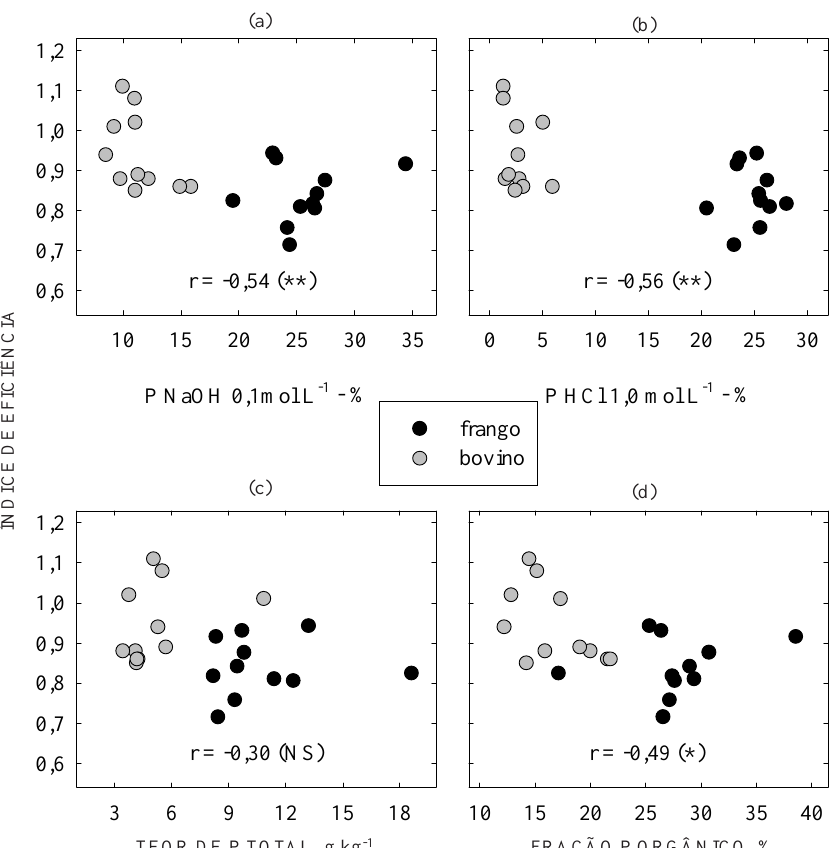
Figura 3. Correlação entre o índice de eficiência de estrumes de frango e de bovino de leite como adubo fosfatado e as proporções do P recuperado em NaOH 0,1 mol L -1 (a), HCl 1,0 mol L -1 (b), teor de P total (c) e somatório de formas orgânicas (d). (NS não-significativo. * Significativo a 5%. ** Significativo a